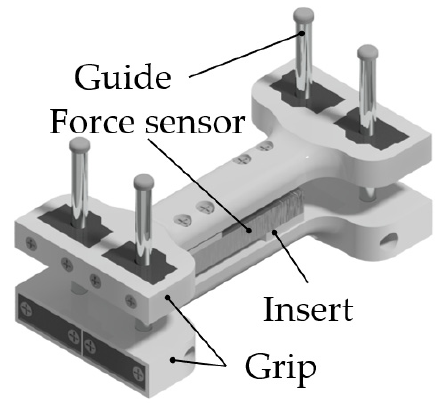
Figure 4. Isometric grasping stand.